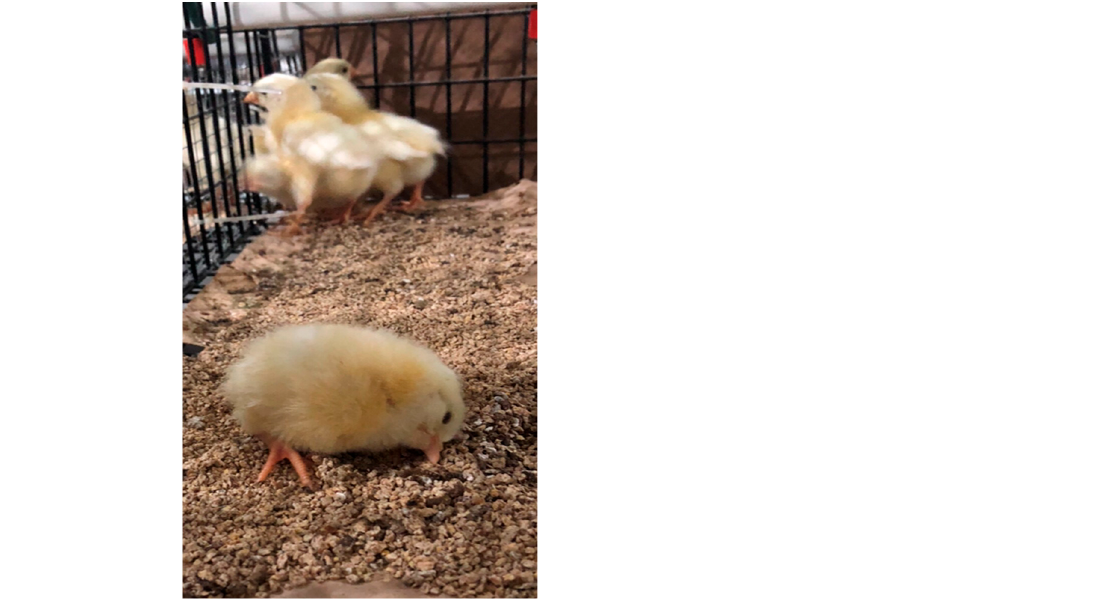
Figure 1. Hy-Line W-36 layer chicks exhibiting twisted and extended necks after receiving the high dose (1.73 × 10 4 CFU) of 6/85 MG in the AM at 18 days of incubation. Chicks in all other treatment groups, including controls and the lower 6/85 MG treatment doses, did not exhibit this behavior.